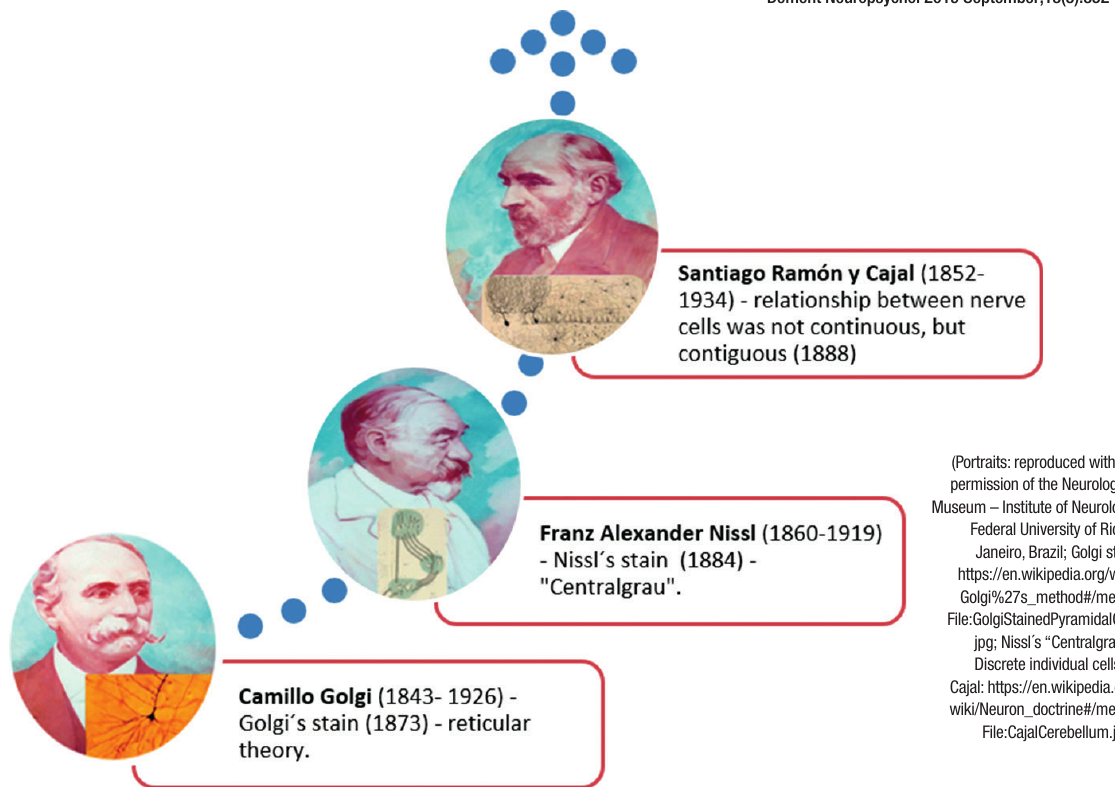
Figure 3. The succession of research into the structure of neurons defined modern study of the nervous system. Nissl refused to accept the nervous network of Golgi, but he presented the “Centralgrau” in the field of speculation-intercellular ‘grey’ between the axons and the dendrites - but not in the anatomical one. Cajal demonstrated the “neuron